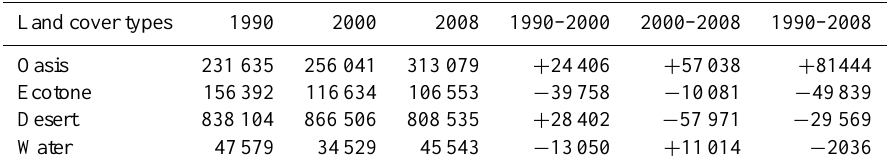
Table 3. Amounts of changes by land cover classification during 1990–2008